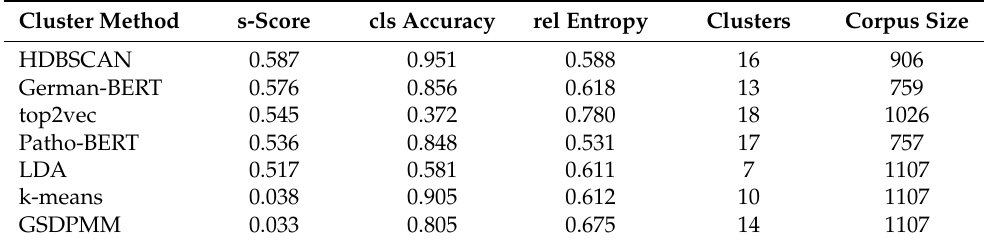
Table 1. Metrics of different